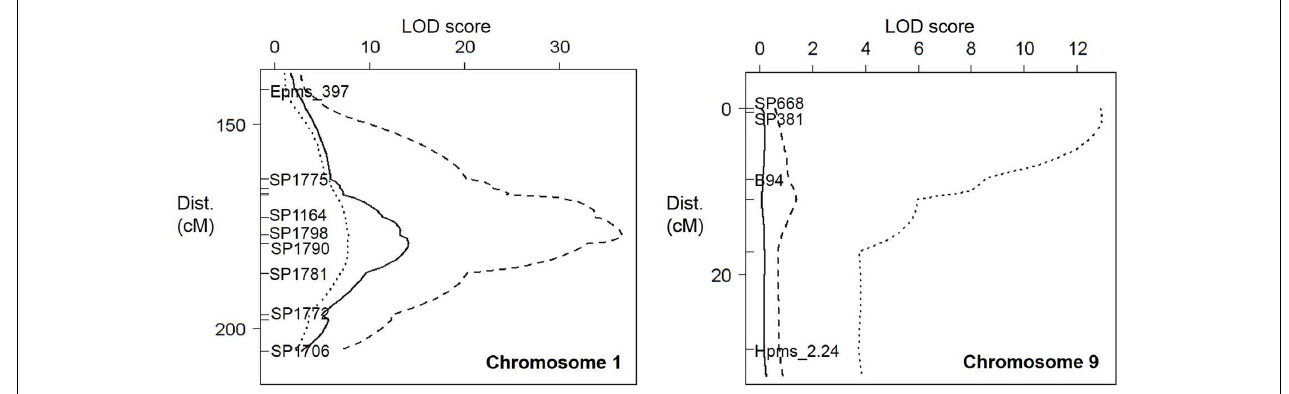
FIGURE 3 | Quantitative trait loci (QTLs) against M. incognita (solid line), M. arenaria (dashed line), and M. javanica (dotted line) on pepper chromosome 1 (Left) and chromosome 9 (Right). On the left of each linkage group (LG), distances in centimorgans, flanking markers, and the marker closest to the resistance factors are indicated.